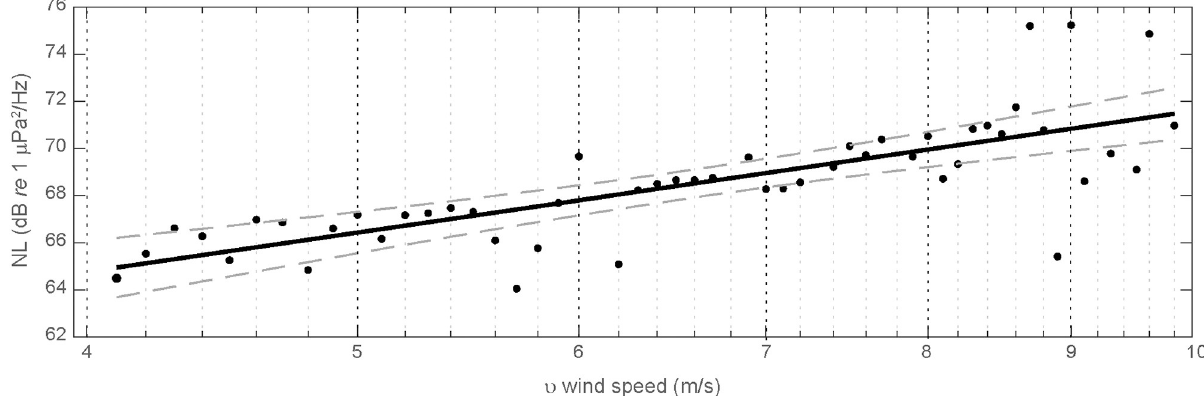
Fig 6. A linear least squares regression fit (R 2 = 0.57, p << 0.05) of frequency band averaged (1–1.05 kHz) median noise levels recorded by the glider as a function of wind speeds measured at buoy 46089. Median noise levels are calculated from 10 cm/s bins and measurements from all depths are combined. 95% confidence intervals are shown as dashed